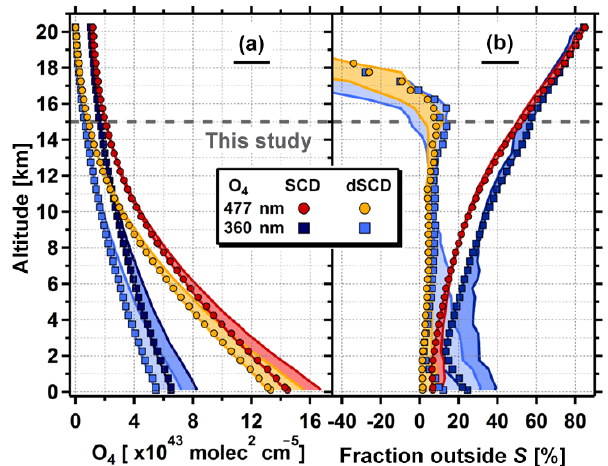
Figure 2. Sensitivity of EA 0 ◦ O 4 measurements at 360 and 477nm with SZA = 25 ◦ (markers) and SZA = 0–70 ◦ (shadings). (a) O 4 SCD and dSCDs values. The reference spectrum to create dSCDs is an EA 10 ◦ spectrum from 14.25km with SZA = 25 ◦ . (b) Fraction of the total SCD/dSCD coming from outside the sensitive range S